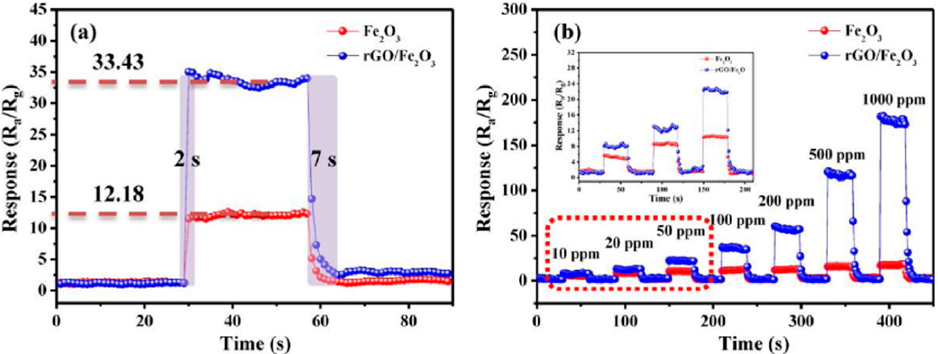
Figure 19. ( a ) Dynamic response–recovery curves (100 ppm TEA) of pure α -Fe 2 O 3 spindles and RGO/ α -Fe 2 O 3 nanocomposites at 280 °C. ( b ) Concentration-dependent response curves of pure α - Fe 2 O 3 spindles and RGO/ α -Fe 2 O 3 nanocomposites to 10–1000 ppm TEA [123]. Yu et al. [124] modified Co 3 O 4 nanoparticles by wrapping RGO via a simple hydro-